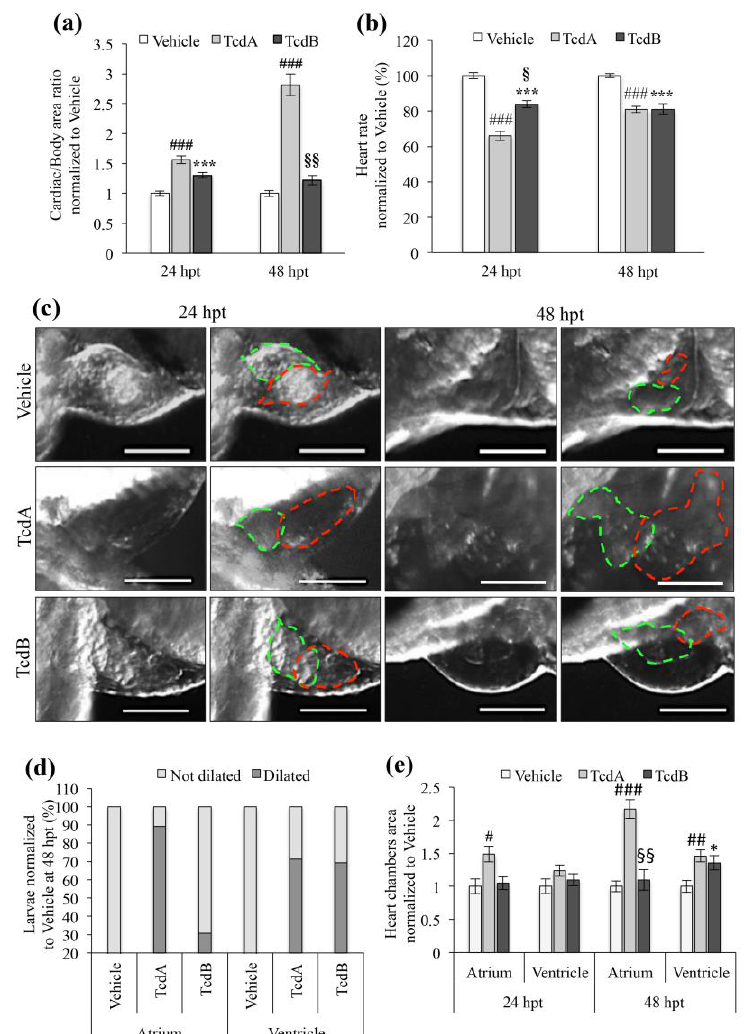
Figure 2. E ff ects of TcdA and TcdB treatment on zebrafish embryos heart. ( a ) Evaluation of pericardial edema in zebrafish embryos 24 and 48 h after administration of vehicle, 2.5 µ g / mL TcdA or 8 µ g / mL TcdB. The histogram displays the ratio of cardiac to total body area. Data are normalized to the vehicle group and are presented as the mean ± SEM. ( n = 30 for each group), ( ### p < 0.001, *** p < 0.001 compared to vehicle; §§ p < 0.001 compared to TcdA). ( b ) Evaluation of the zebrafish embryo heart rate after toxins treatment (2.5 µ g / mL TcdA or 8 µ g / mL TcdB). Data are presented as the mean ± SEM. ( n = 50), ( ### p < 0.001, *** p < 0.001 compared to vehicle; § p < 0.01 compared to TcdA). ( c ) Representative images of the embryos heart chambers after toxins (2.5 µ g / mL TcdA or 8 µ g / mL TcdB) or vehicle administration. On the left part on the panel, images taken at 24 hpt while on the right part of the panel images taken at 48 hpt. Red dashed lines show atrium while green one marked ventricle. Images were acquired with a Leica S8AP0 stereo microscope. Scale Bar = 200 µ m. ( d ) E ff ects of 2.5 µ g / mL TcdA or 8 µ g / mL TcdB administration on the embryos heart chambers at 48 hpt. ( n = 20). Data are normalized to vehicle and shown as the mean ± SEM ( n = 20 for each group) ( e ) Quantization of embryos heart chamber area after toxins (2.5 µ g / mL TcdA or 8 µ g / mL TcdB) or vehicle treatment. Data, normalized to vehicle, are represented as the mean ± SEM. ( n = 20 for each group), ( # p < 0.05, ## p < 0.01, ### p < 0.001, * p < 0.05 compared to vehicle; §§ p < 0.001 compared to